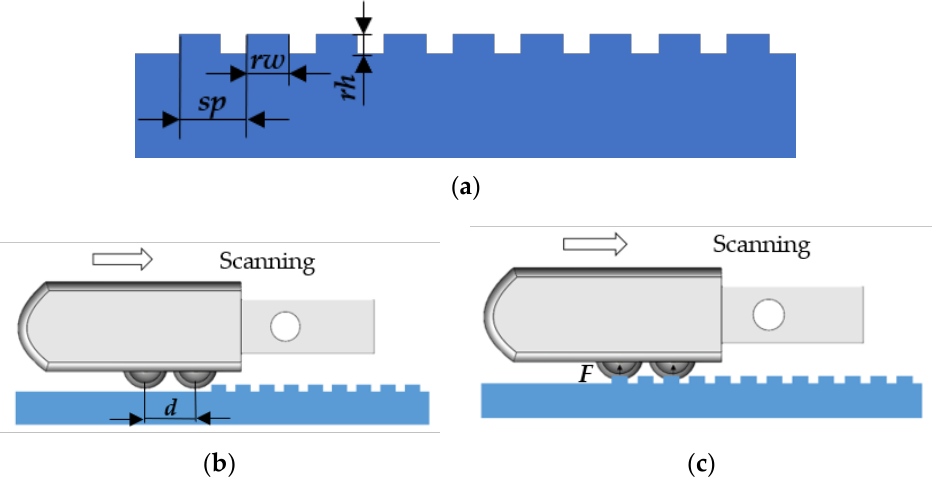
Figure 2. Schematic diagram of texture detection of tactile sensor array: ( a ) cross-section diagram of the ridge texture sample; ( b ) fingertip integrated with tactile sensor array starting to slide; ( c ) ridge of texture compressing the sensing cell.